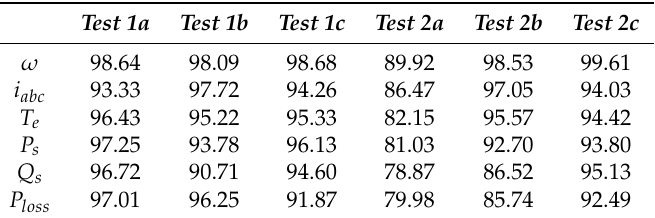
Table 1. Fidelity measures for the